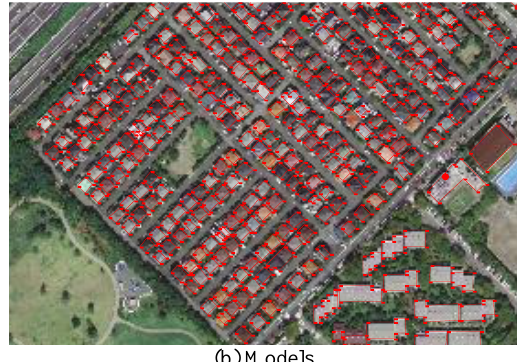
Figure 5 The models of the extracted buildings